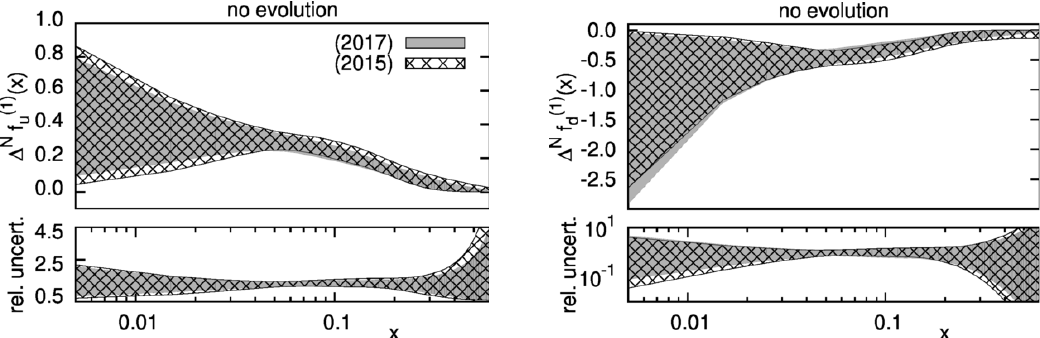
Figure 8 . Uncertainties on the (cid:12)rst moments of the Sivers distribution for u = u v + (cid:22) u (left panel) and d = d v + (cid:22) d (right panel). The shaded bands correspond to our estimate of 2 (cid:27) C.L. error for (cid:11) -(cid:12)t case. In both panels, the gray bands correspond to the (cid:12)t which includes the new COMPASS- 2017 data [9] for h + and h (cid:0) production o(cid:11) NH 3 target, while the meshed areas correspond to the uncertainties obtained when the COMPASS-2015 data from the older analysis [35] are included. The lower panels show the relative errors, given by the ratio between the upper/lower border of the uncertainty bands and the best-(cid:12)t curve for the reference (cid:12)t.